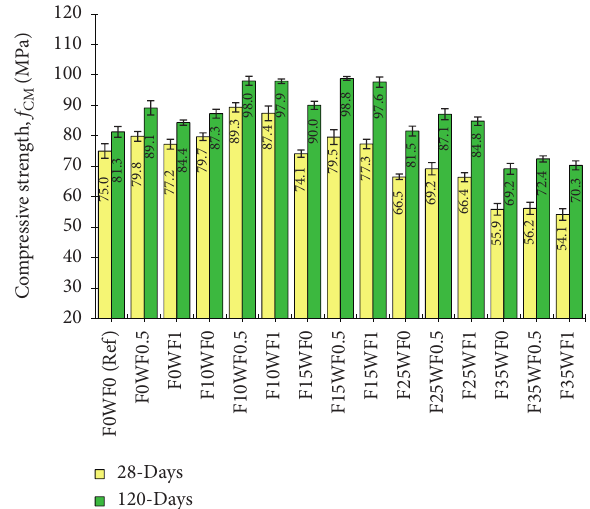
Figure 5: Effect of FA and WSF combinations on compression testing results of